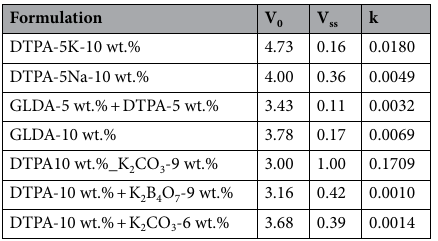
Table 2. Model parameters, Eq. (4), for the different formulations.